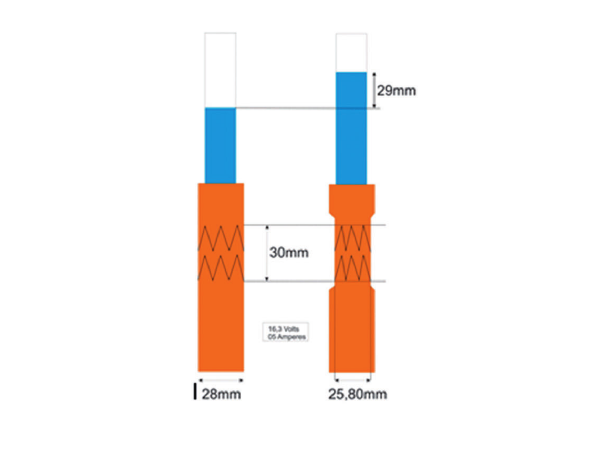
Fig. 5 - Schematic of the first test sequence